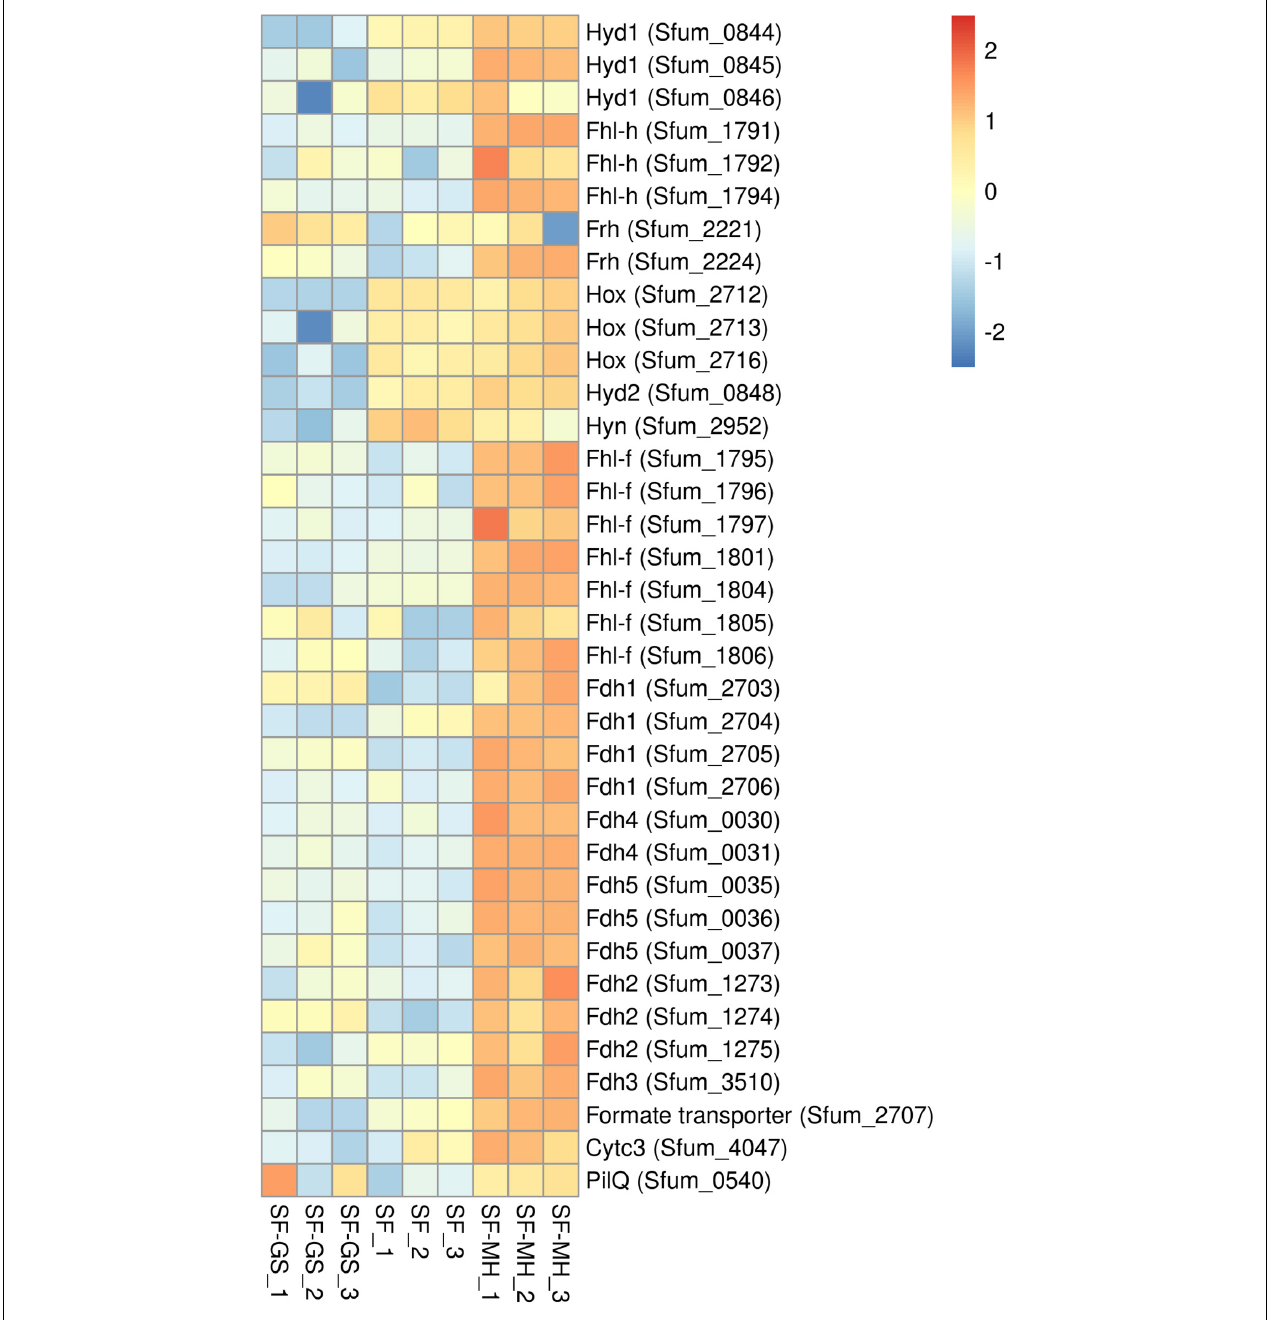
FIGURE 4 | Relative abundance levels of detected hydrogenases and formate dehydrogenases of SF in the SF-GS coculture versus the SF pure culture and the SF-MH coluture. Protein abundance levels are shown after Z -score normalization. Protein abundance levels are shown after Z -score normalization. The colour intensity indicates the degree of protein presence, where high relative abundance is indicated in red and low relative abundance in blue. The rows in the heat map show the detected proteins in the SF-GS coculture, the SF pure culture and the SF-MH coulture. The columns show the cultures in triplicates. Clustering shows that samples grouped according to treatments even when only enzymes in this set are considered ( Supplementary Figure 6